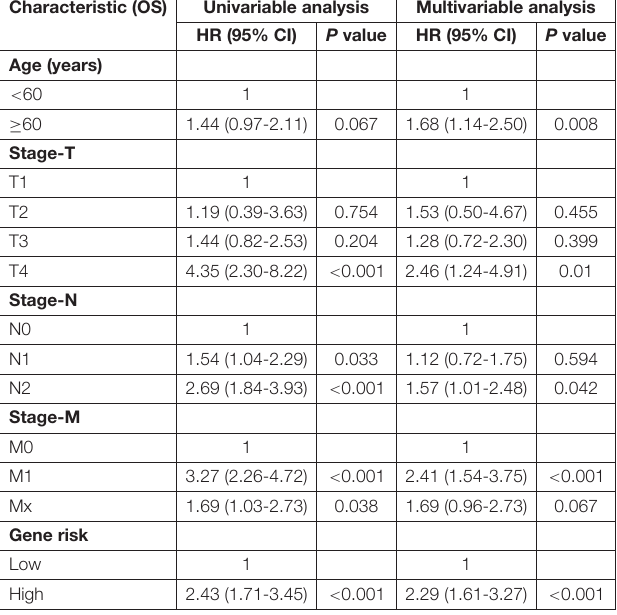
TABLE 1 | Univariable and multivariable Cox regression analysis of OS in cRC patients. Characteristic (OS) Univariable analysis Multivariable